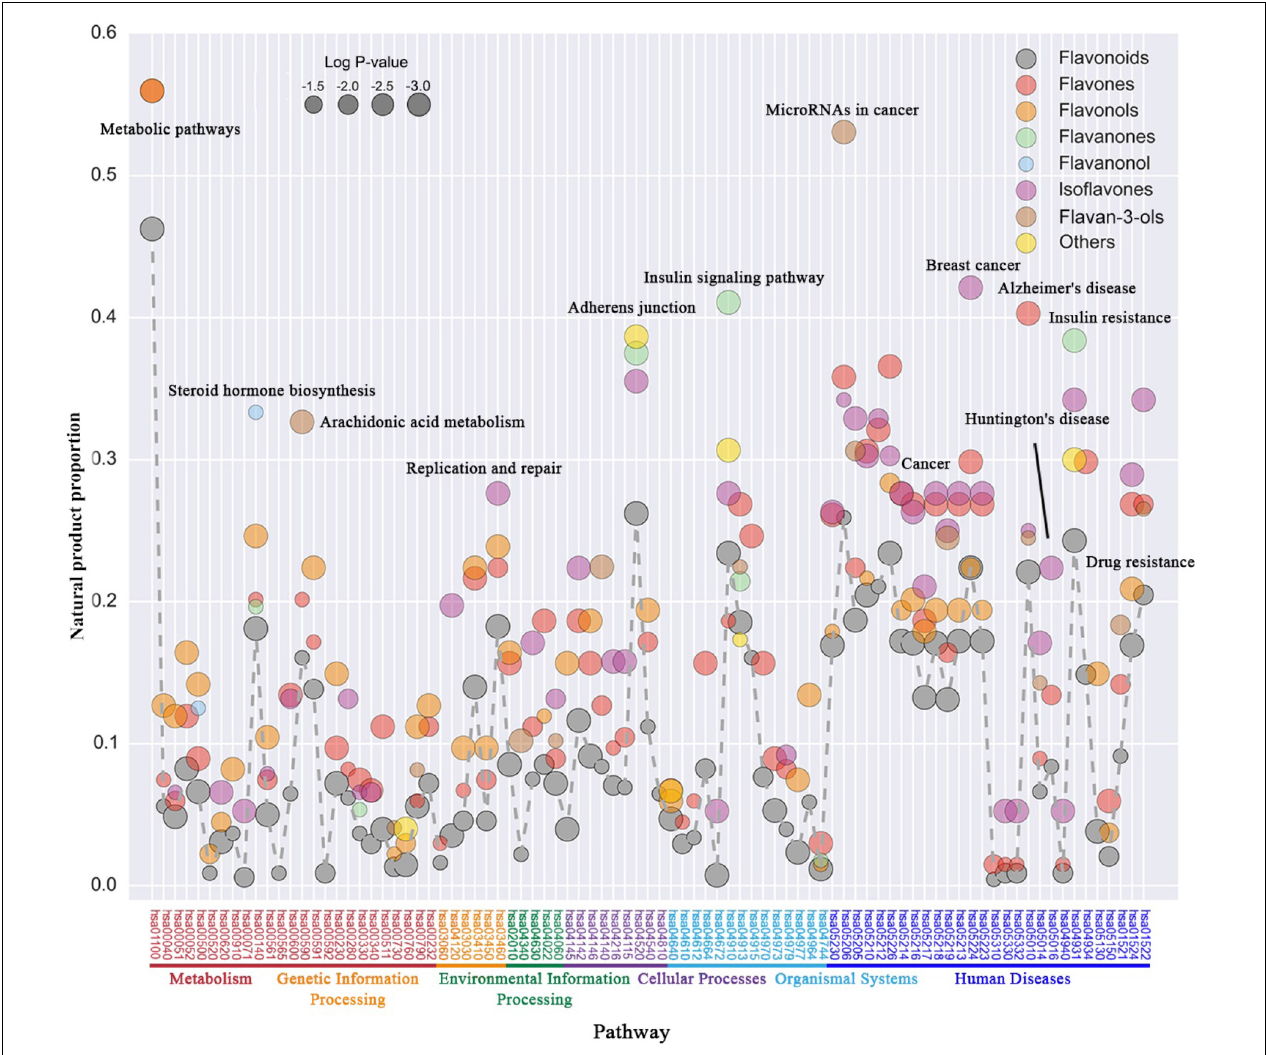
FIGURE 3 | Specific KEGG pathway enrichment analysis of natural flavonoid products’ targets. Here, X -axis represents the enriched pathways ( p -value < 0.05), which were categorized according to KEGG classification. Y -axis represents compound proportion of flavonoids in each pathway (number of target related compounds/total number of compounds in each class), the size of each nodes represented the significance of enrichment level (–LogP). Flavonoids and all six subclasses were marked in different colors.